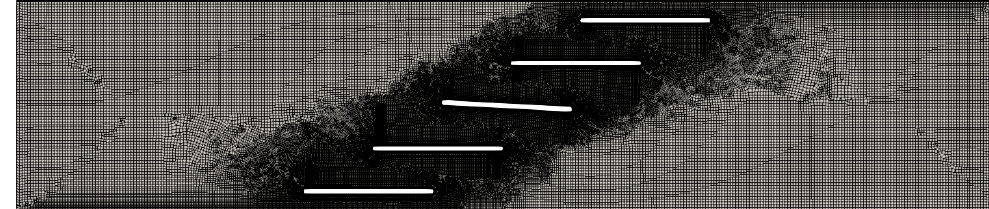
Figure 2. Coarse mesh for the case with α = 3°.